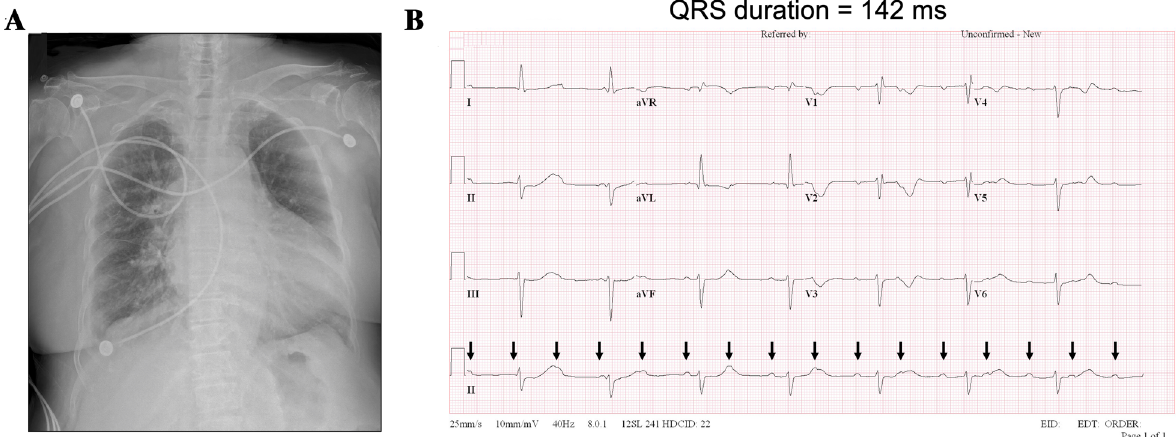
Fig. 1 Baseline electrocardiogram and chest X‑ray showed complete atrioventricular block with ventricular escape rhythm with a QRS duration of 142 ms, cardiomegaly, and pulmonary edema. The black arrows denote P